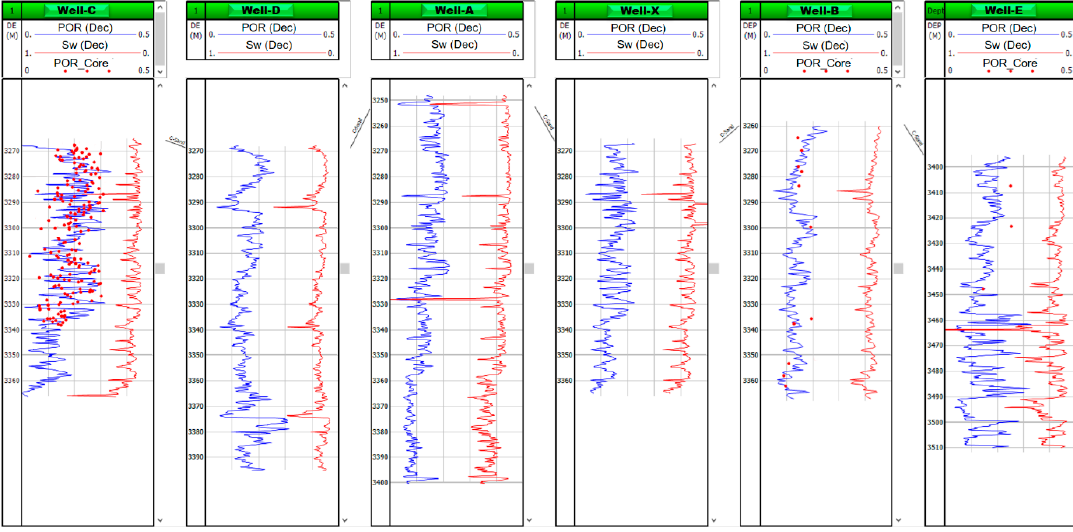
Figure 4. Estmated petrophysical properties of reservoir C-sand interval in the study wells; estimated values are shown in continuous lines while laboratory measurement results are indicated with red dots.